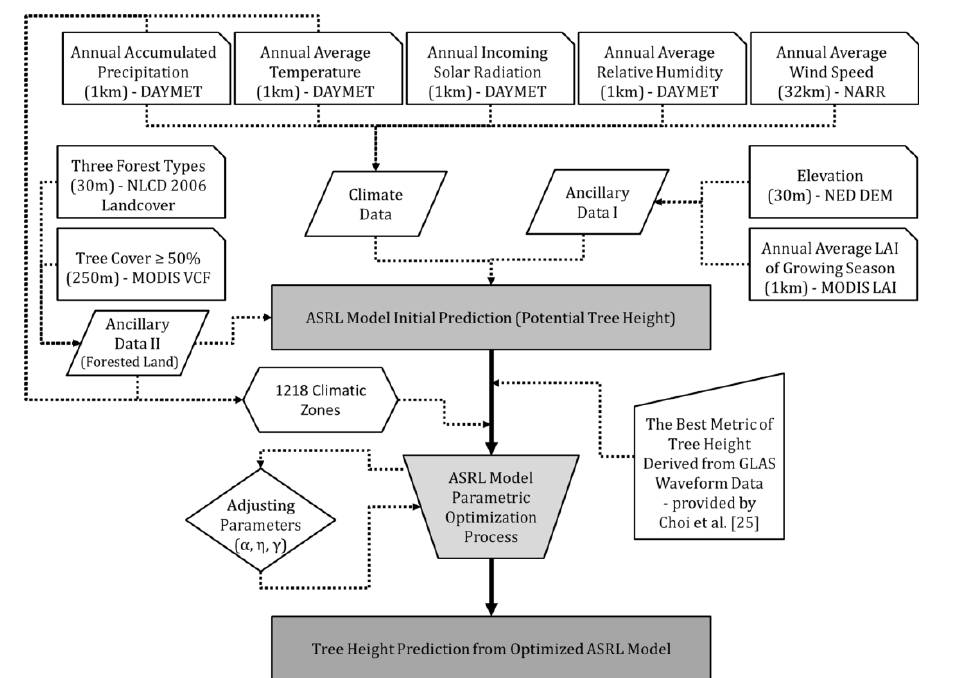
Figure 2. Diagram showing the optimization of the ASRL model. The model predicts potential tree heights (initial prediction) based on input climatic and ancillary variables. Three allometric scaling parameters (area of single leaf, α, exponent for canopy radius, η and root absorption efficiency, γ) are adjusted in the optimization process to minimize the difference between GLAS tree heights and ASRL modeled tree heights. This optimization process is done separately for each of the climatic